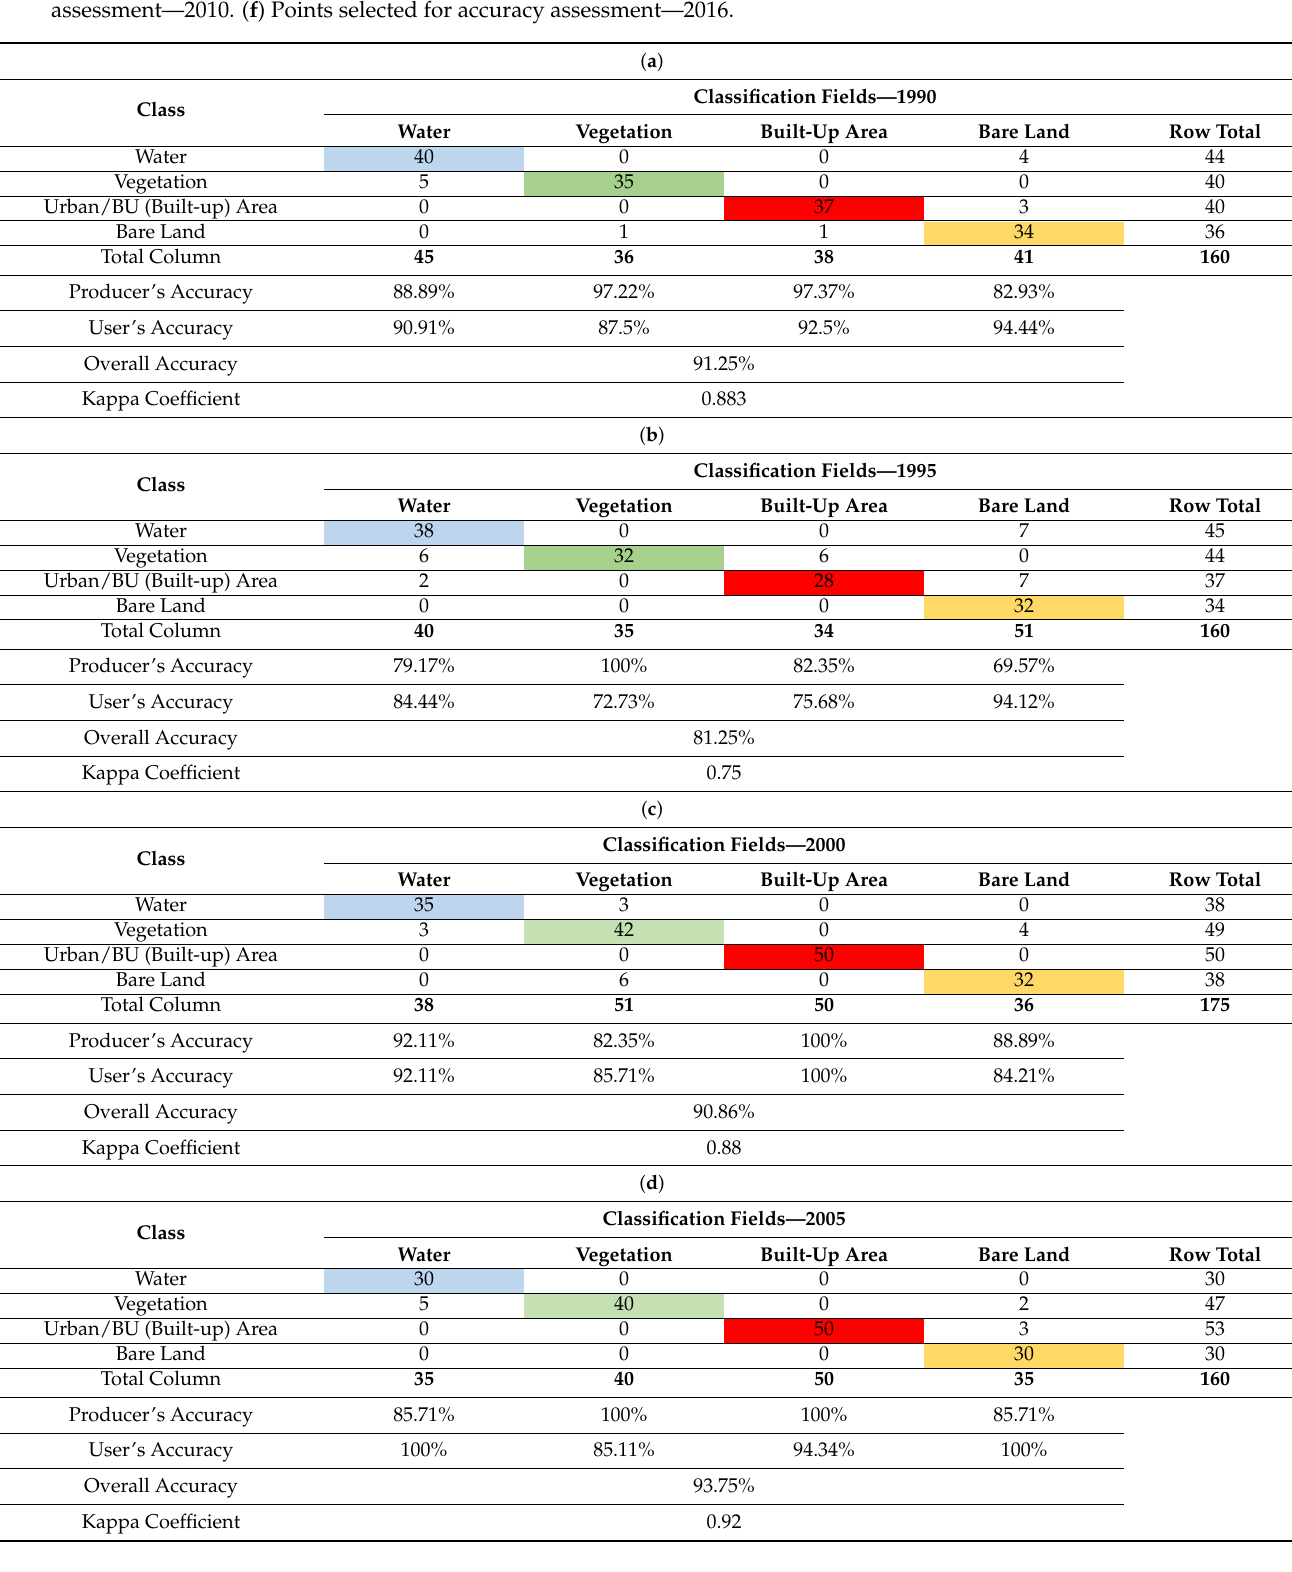
Table 4. ( a ) Points selected for accuracy assessment—1990. ( b ) Points selected for accuracy assessment—1995. ( c ) Points selected for accuracy assessment—2000. ( d ) Points selected for accuracy assessment—2005. ( e ) Points selected for accuracy assessment—2010. ( f ) Points selected for accuracy